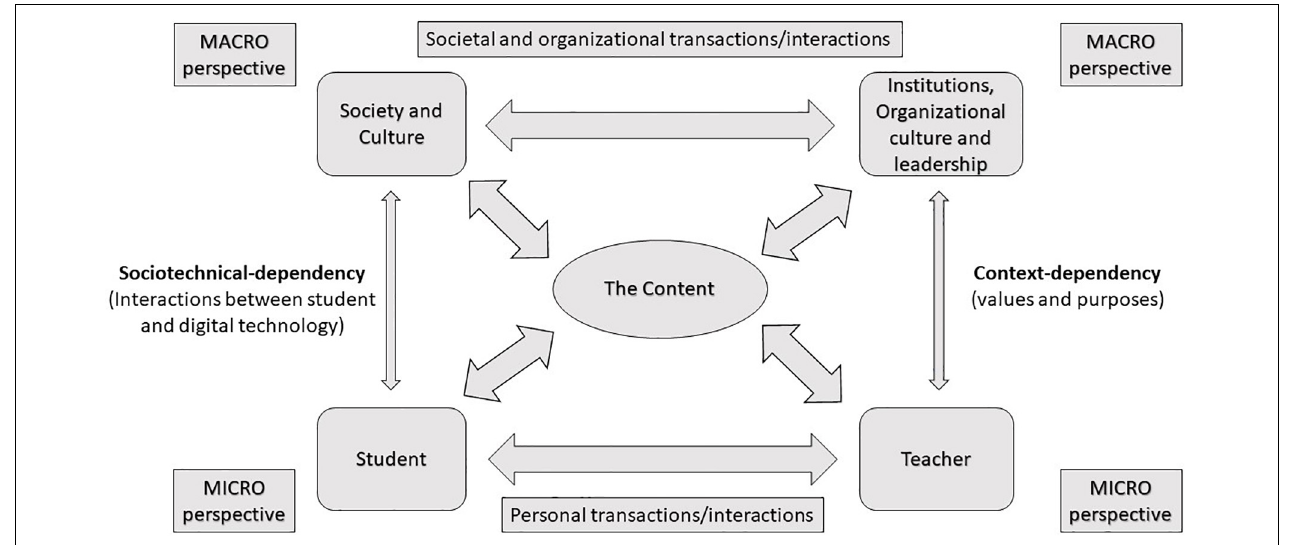
FIGURE 1 | The complex system